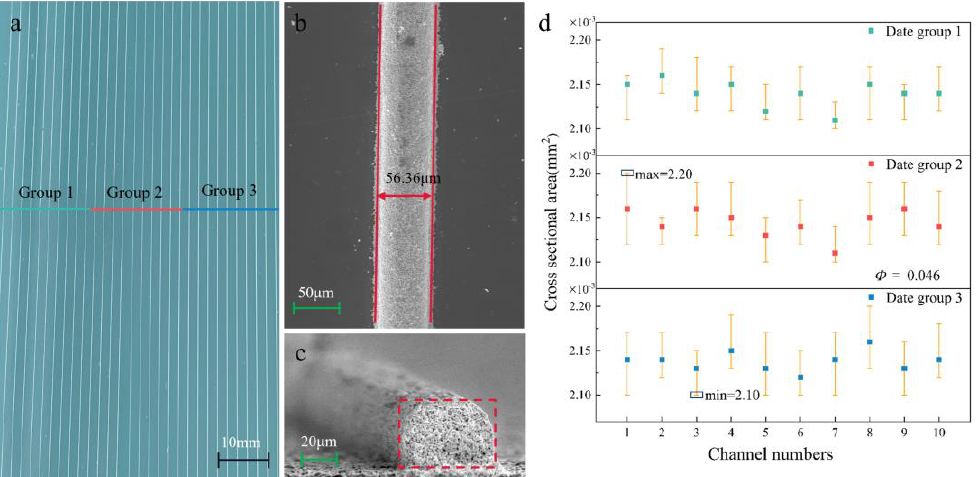
Figure 13. Multi-nozzle array direct printing results. ( a ): Experimental results; ( b ): Scanning electron microscope shooting of lines; ( c ): The cross-sectional area of the fluid line measurement and calculation; ( d ): Data (cross-sectional area from Figure 13c) analysis and calculation.